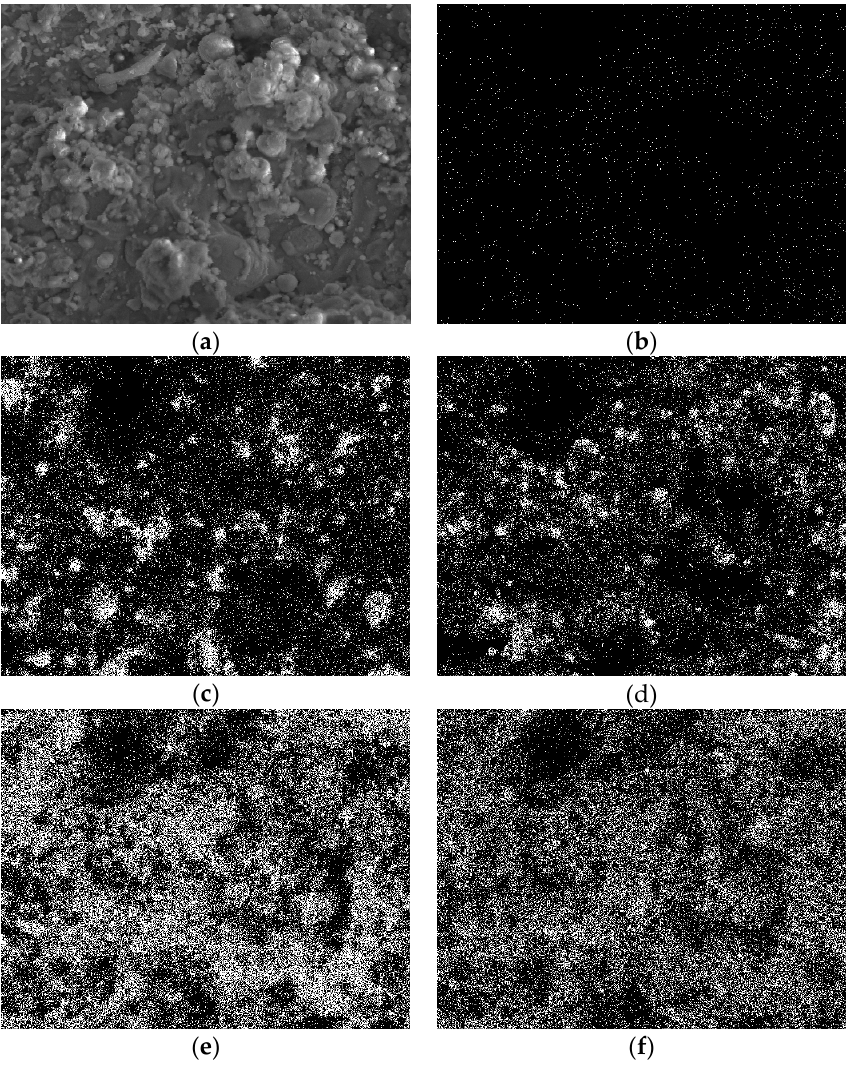
Figure 3. Elements distribution on the upper surface of NiCr–TiB 2 –ZrB 2 coating: ( a ) NiCr–TiB 2 –ZrB 2 coating; ( b ) B; ( c ) Ti; ( d ) Zr; ( e ) Ni; and ( f ) Cr.